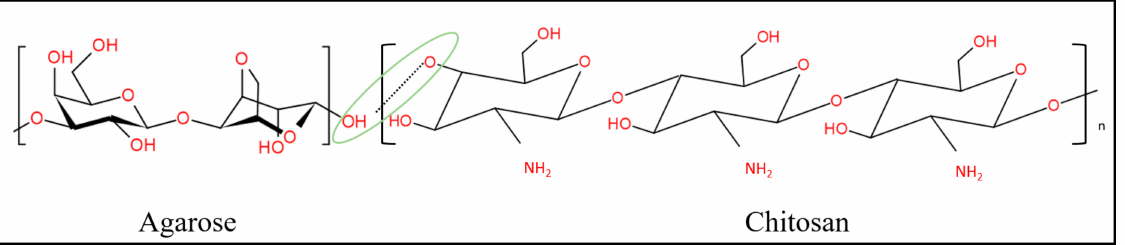
Figure 6. Illustration of secondary doping of PEDOT: PSS using DMSO organic solvent.